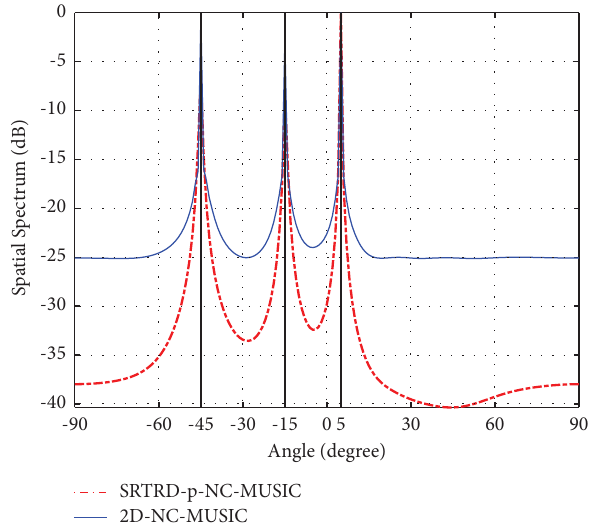
Figure 5: Spatial spectrum of the proposed SRTRD-p-NC-MUSIC and the 2D-NC-MUSIC, SNR � 5 dB and L �